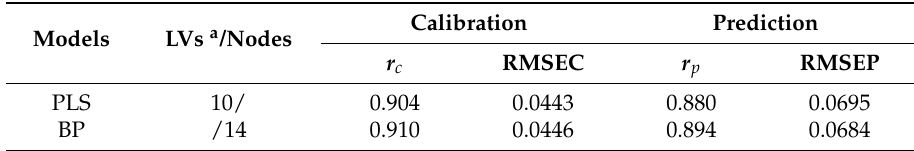
Table 2. The results of PLS model and BPNN model on full spectra.